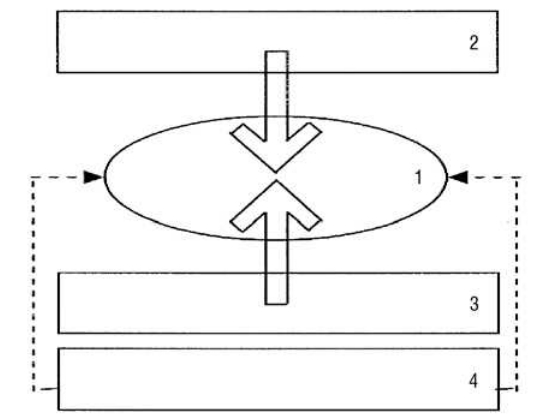
sas; 3 – atskirųjų želdynų grupė; 4 – į kitos paskirties žemių teritorijas integruotų želdynų grupė, sistemoje atliekanti antraeilį vaidmenį Fig 6. Structural model of green area groups forming urban green area